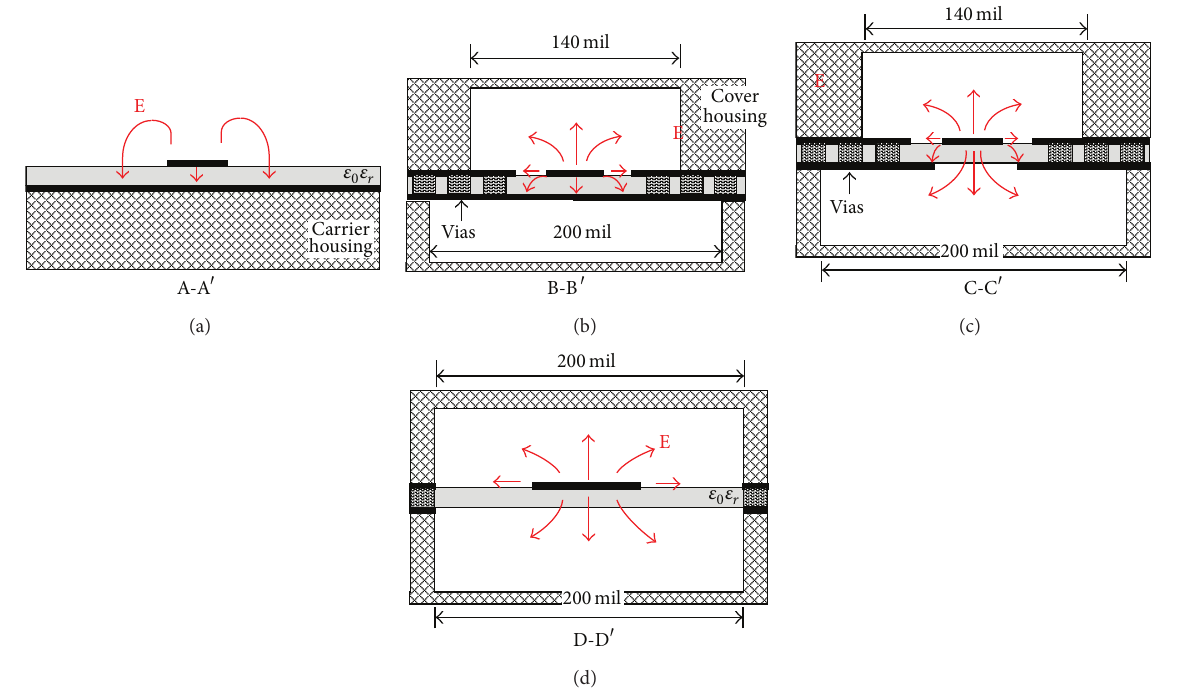
Figure 3: Cross-sectional views of simplified electric field distributions. Table 1: Summary of the SSL channel dimensions (unit: mil). Table 2: Summary of the transition dimensions (unit: